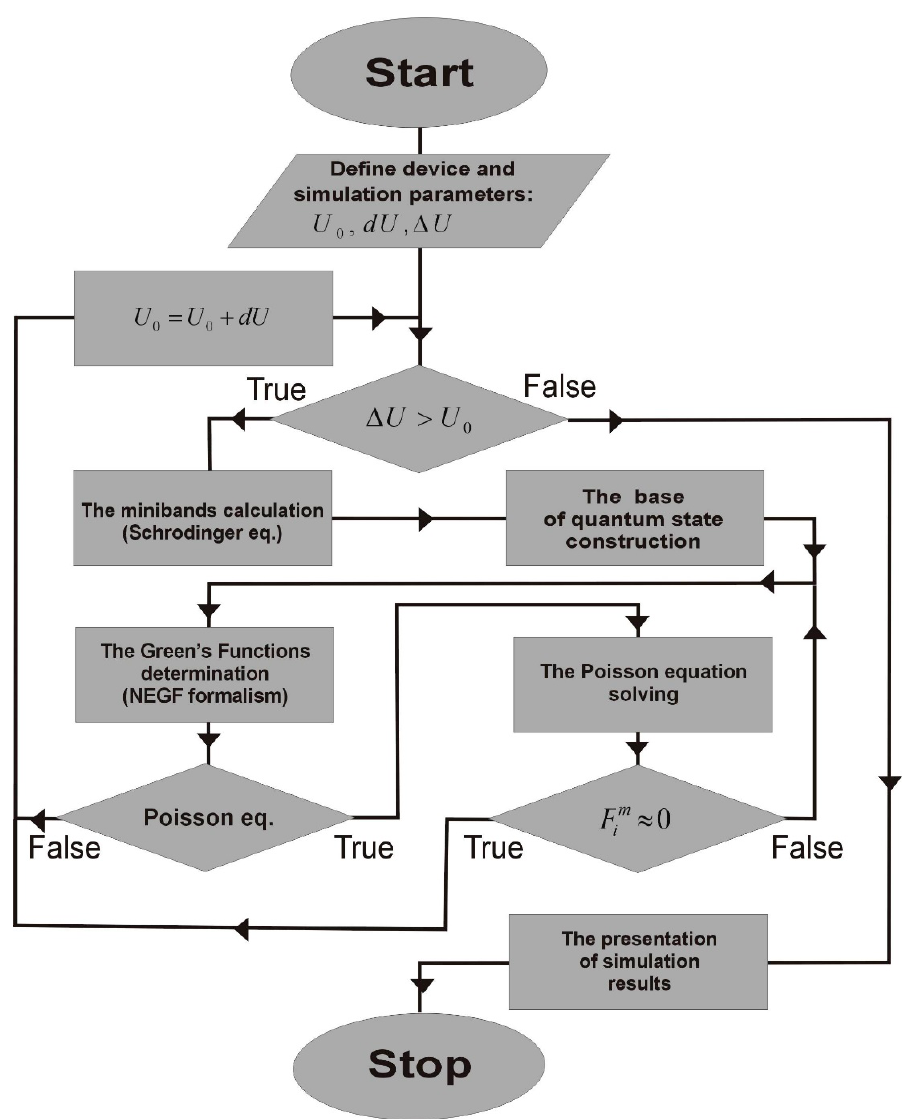
Figure 2. The main algorithm of the superlattice simulations executed with superlattice simulator (SLSim) program. In this implementation, Δ U means the total range of the U/I characteristic, while dU is a calculation step for individual points of this characteristic.